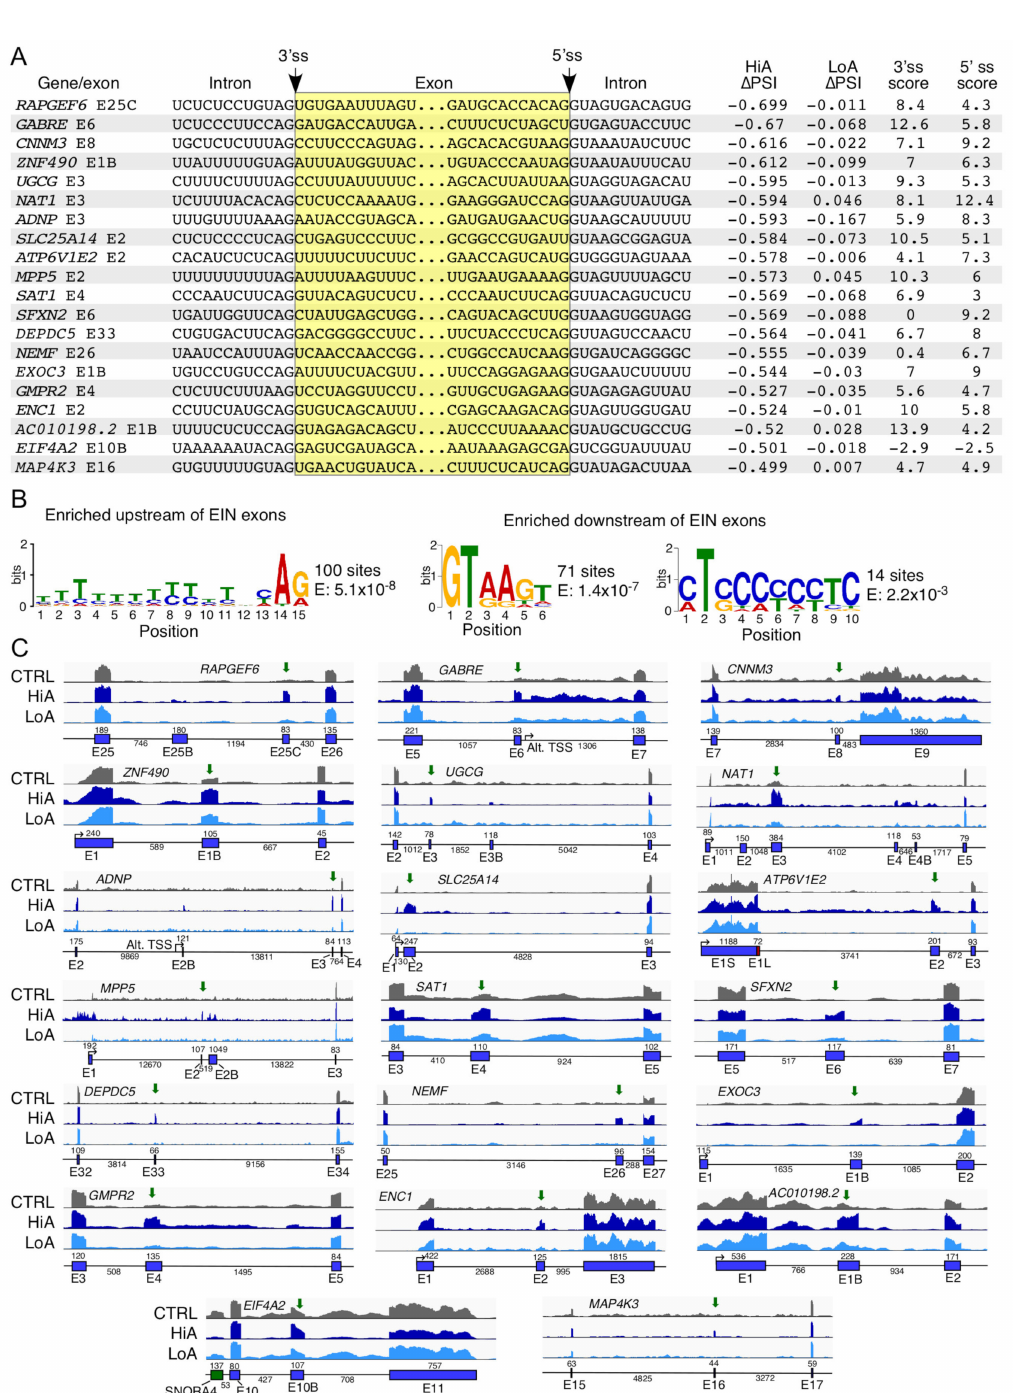
Figure 3. Increased exon inclusion caused by Anti-N1 treatment. ( A ). The sequence context of 20 candidate exons exhibiting greatly increased inclusion upon Anti-N1 treatment; 12 nt-long sequences on either side of the 3 (cid:48) ss and 5 (cid:48) ss of each affected exon are provided. Exonic sequences are highlighted by a yellow box. The 3 (cid:48) ss and 5 (cid:48) ss are indicated by arrows. At the right of each sequence, the change in skipping ( ∆ PSI) under HiA and LoA treatment are provided, along with the predicted strength of each 3 (cid:48) ss and 5 (cid:48) ss. ( B ). Enriched sequence motifs identified by MEME. Left panel: the most enriched motif within 50 nucleotides upstream of the 3 (cid:48) ss of the affected exons, corresponding to the polypyrimidine tract and the 3 (cid:48) ss sequence. Middle and right panel: two motifs enriched downstream of the 5 (cid:48) ss of the affected exons. The first motif matches the consensus 5 (cid:48) ss and the second represents a C- and U-rich motif of unknown significance. n = 100 sequences. ( C ). Genomic views of several candidate exons whose inclusion was increased upon Anti-N1 treatment. The ASO treatments are indi- cated at the left side. The name of the host gene is provided at the top of each panel; exon locations and their names are shown below each panel. Exons are depicted by blue boxes, introns by black lines. Exon sizes are indicated above each exon,